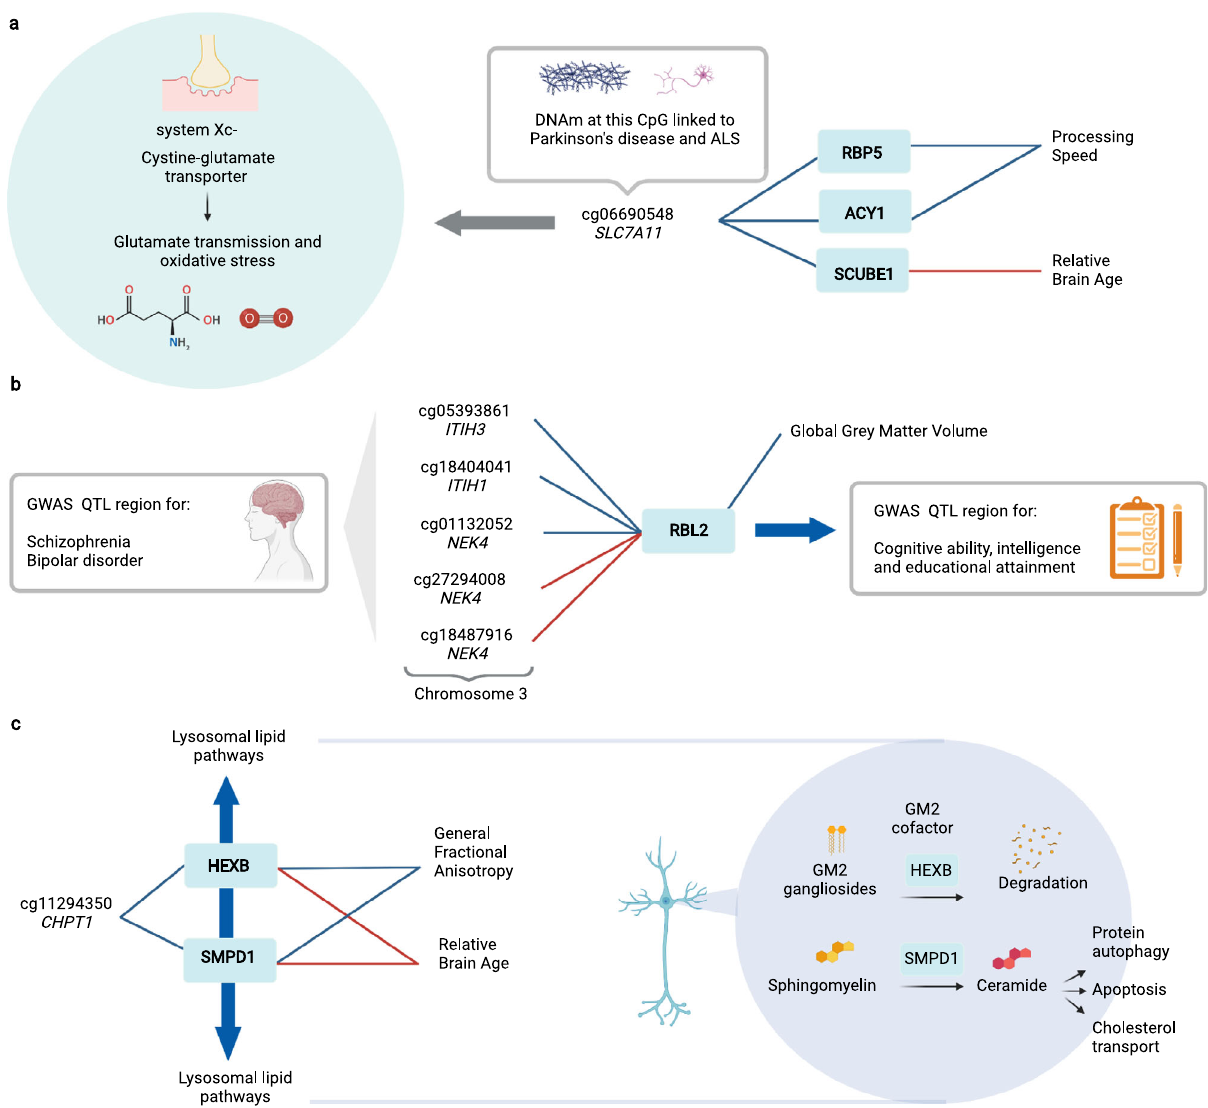
Fig.6|Explorationof trans pQTMsforproteinmarkersofbrainhealth.a Three trans associations with the CpG site cg06690548 in the SLC7A11 gene, which encodesasynapticproteinthatisinvolvedinglutamatetransmissionandoxidative stress. cg06690548hasbeen implicatedin methylome-widestudiesofParkinson ’ s disease and Amyotrophic lateral sclerosis (ALS) risk. b Five trans associations between CpGs in the ITIH3/ITIH1/NEK4 region on chromosome 3 and the levels of RBL2,whichwasassociatedwith lower GlobalGrey Matter Volume. The RBL2 gene has been implicated in genome-wide associations studies (GWAS) of cognitive ability, intelligence and educational attainment. The ITIH3/ITIH1/NEK4 region has